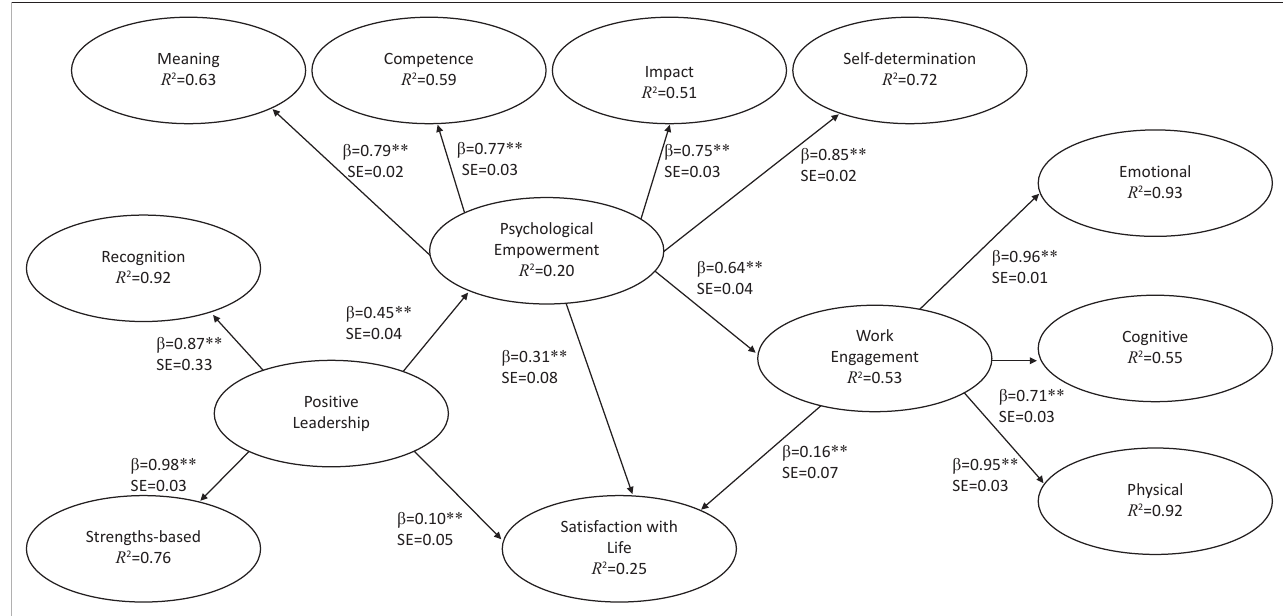
FIGURE 2: Maximum likelihood estimate for the hypothesised model. * p <.05. ** p